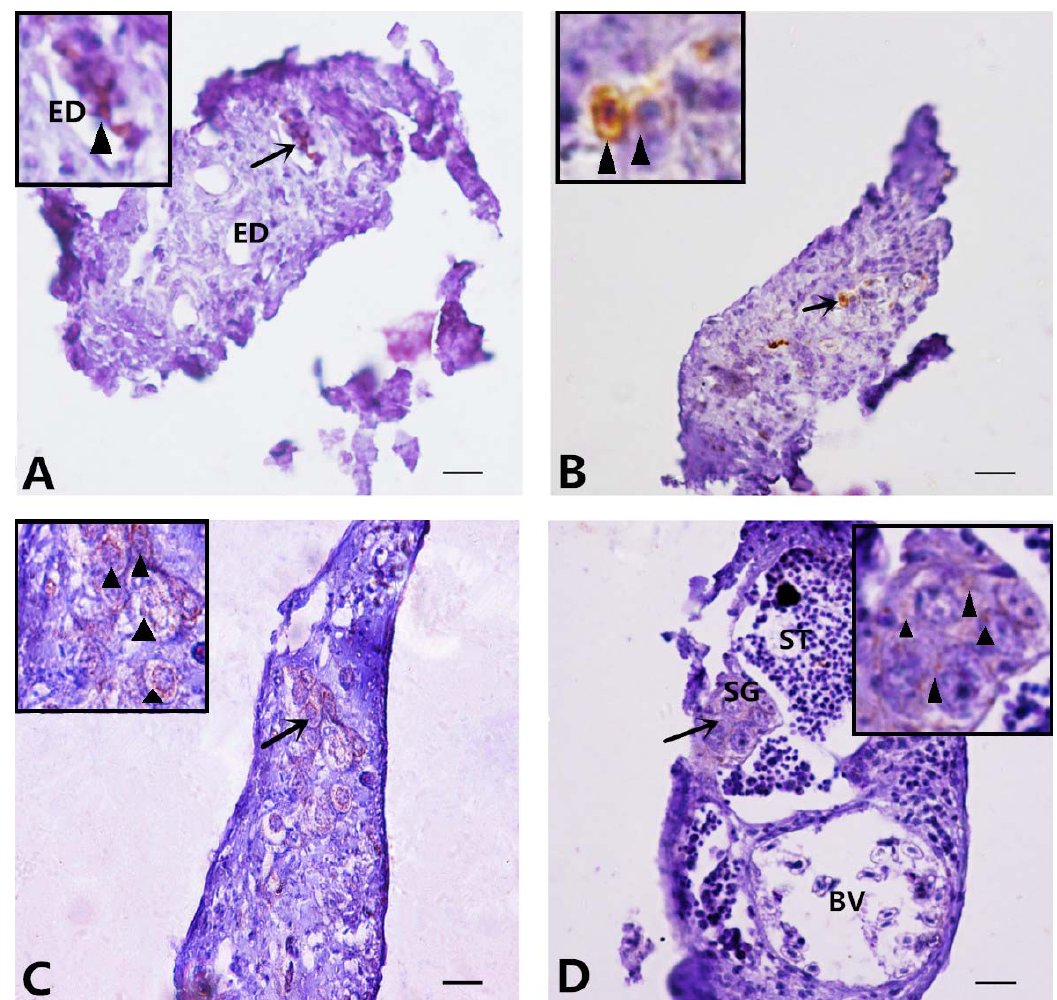
Figure 4. Tracing of Dmrt1-expressing cells during MT-feeding-induced sex reversal. The black arrows show the high magnification of the picture. Scale bars, 25 μ m. Dmrt1 is detected in goniae cells around the efferent dust (black arrowheads) of MT-feeding fish at 12 dat ( A ). Dmrt1 is detected in a few of spermatogonia scattered in the gonads (black arrowheads) at 24 dat ( B ), and then they appear in gathered spermatogonia (black arrowheads) at 36 dat and 96 dat ( C , D ) of the MT-feeding fish. ED: efferent dust; BV: blood vessel; SG: spermatogonia; ST: spermatid. TUNEL (terminal deoxynucleotidyl transferase 2-deoxyuridine, 5-triphosphate nick end